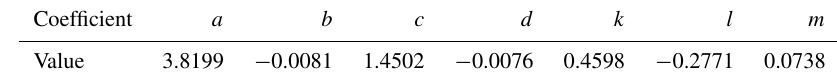
Table 1. The coefficients used to determine CMF EUV based on CMF GLB and SZA by the means of nonlinear regression. Coefficient a b c d k l m Value 3.8199 − 0.0081 1.4502 − 0.0076 0.4598 − 0.2771 0.0738